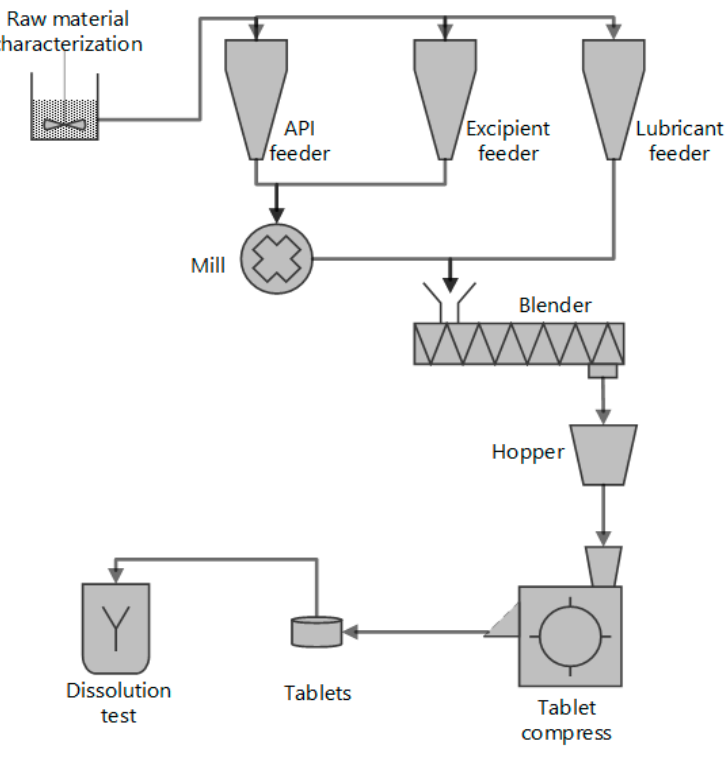
Figure 6. Continuous tablet compression process.